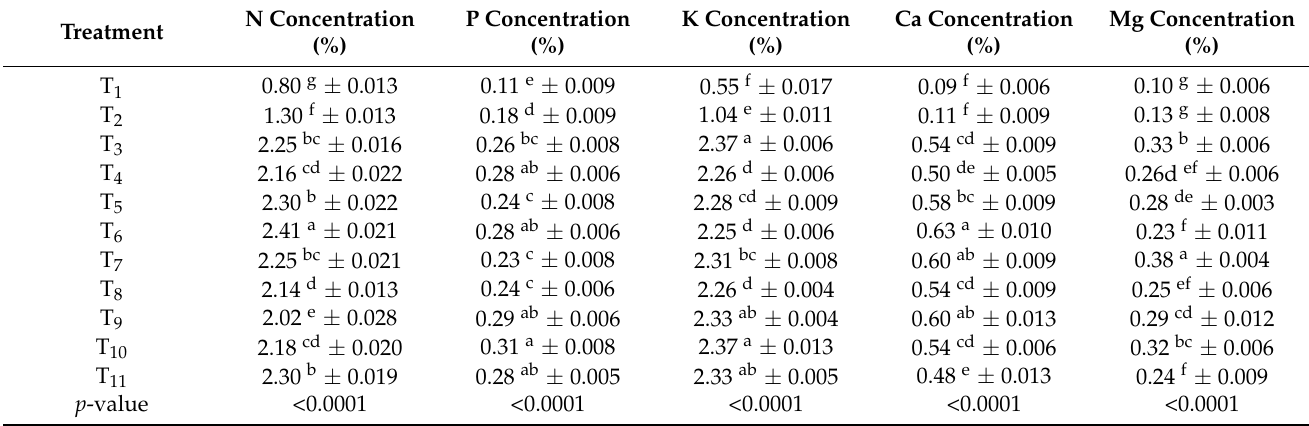
Table 7. Effect of treatments on changes in plant nutrient concentration.